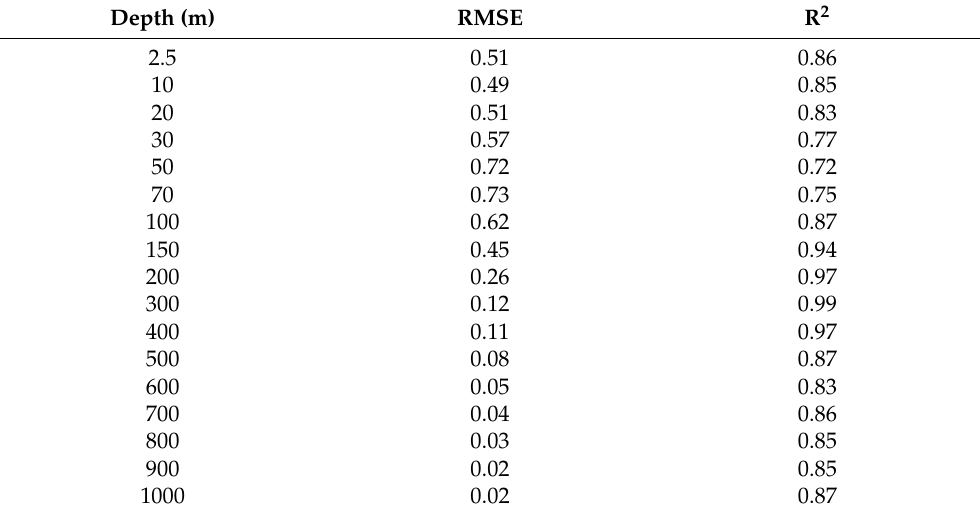
Table 5. Vertical distributions of RMSE (°C) and R 2 for Ens-ML model at different depths. Depth (m) RMSE R 2